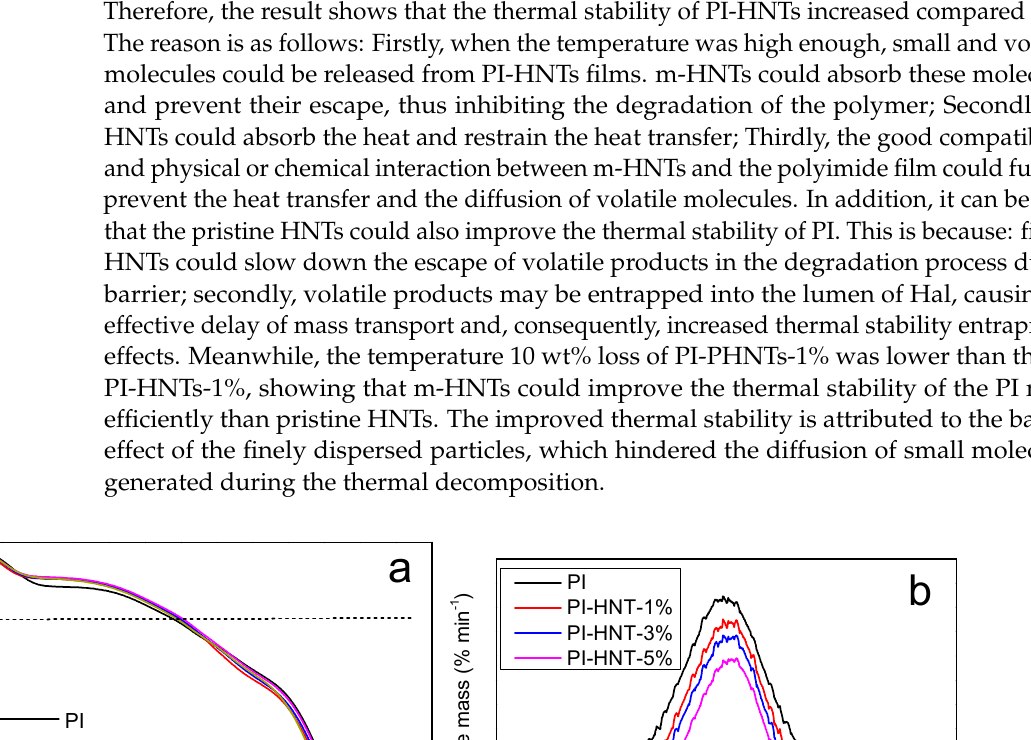
Table 3. The peak temperatures of the samples of PI, PI-HNTs-1%, PI-HNTs-3%, and PI-HNTs-5%.